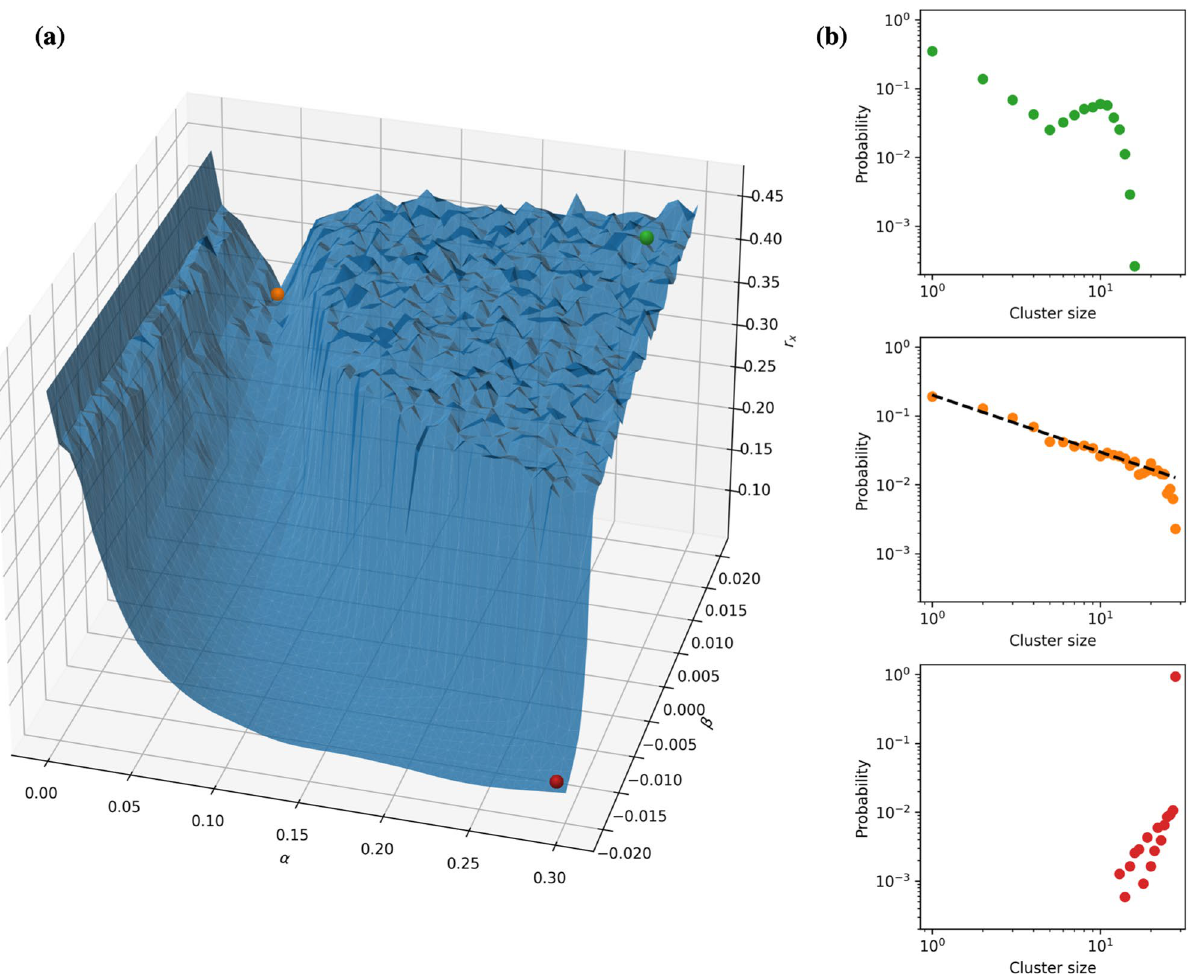
28 spin torque = 0.0306 , β 0.0192 ), = =